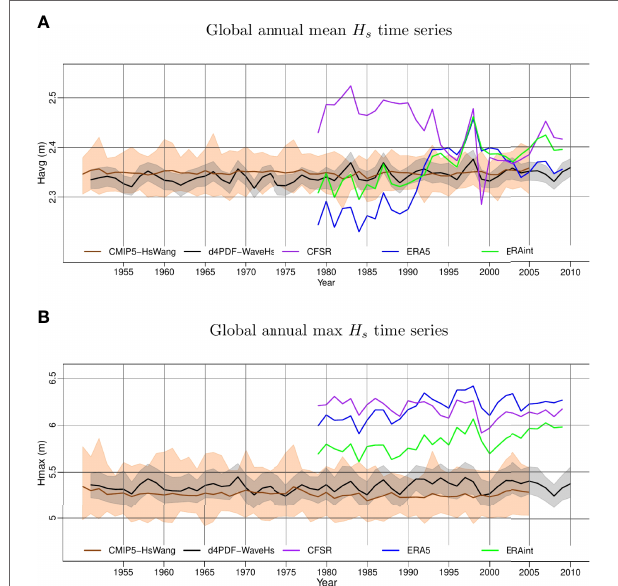
FIGURE 4 | Global time series of the annual mean H s (A) and annual maximum H s (B) , in m, as derived from d4PDF-WaveHs (black), CMIP5- HsWang (brown), CFSR (purple), ERA5 (blue), ERAint (green). For the d4PDF- WaveHs and CMIP5-HsWang ensembles we show the ensemble mean (thick lines) and the range between the 2.5% and 97.5% percentiles (shaded area).